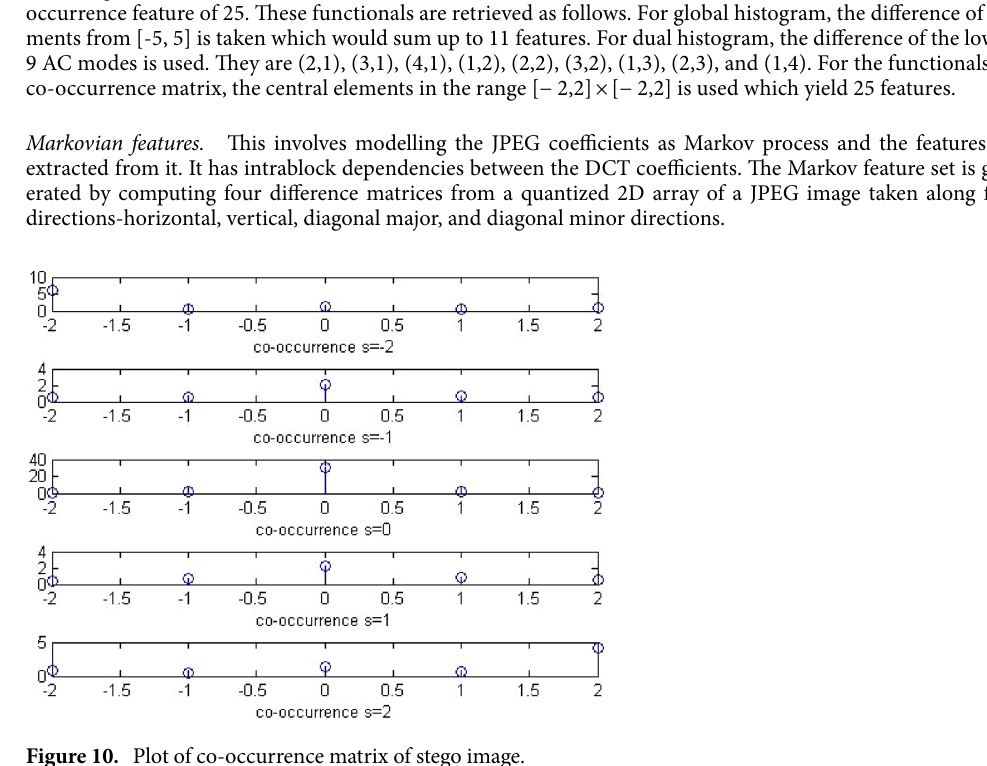
Figure 10. Plot of co-occurrence matrix of stego